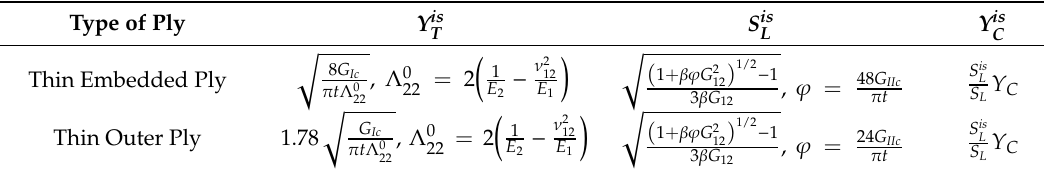
Table 5. Analytical formulas to calculate the in situ